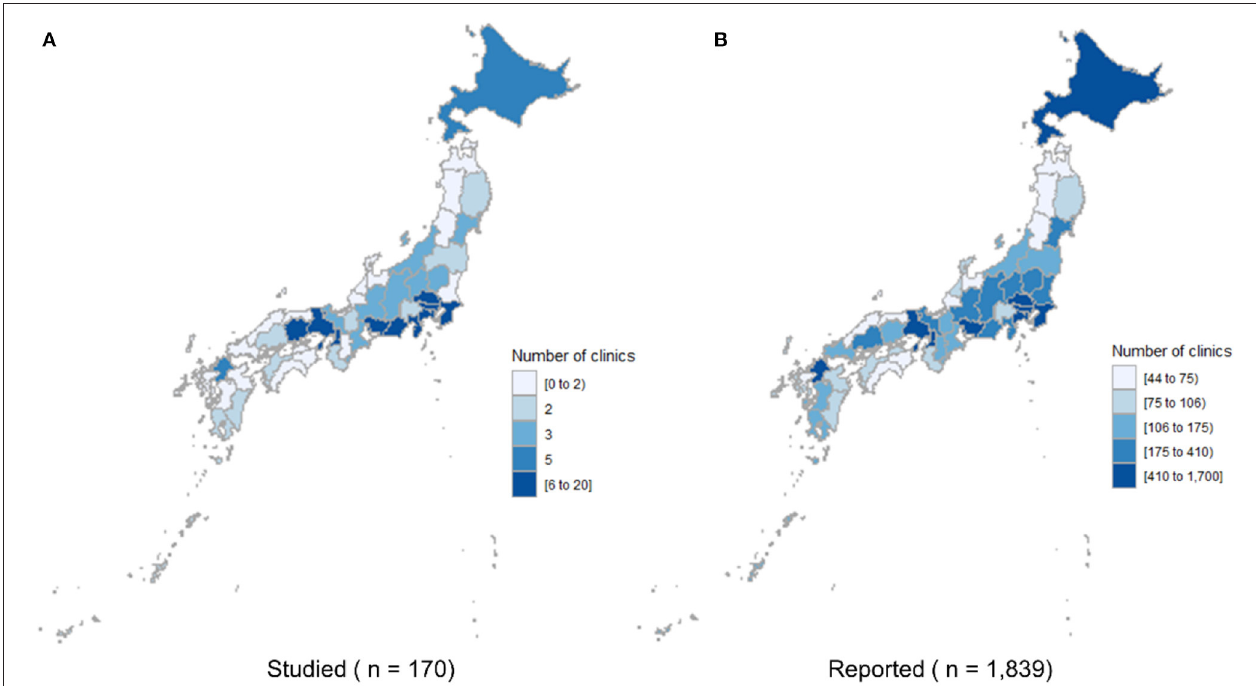
FIGURE 1 | Choropleth maps showing the number of companion animal clinics studied (A) and the number reported to the government (B) by prefecture.